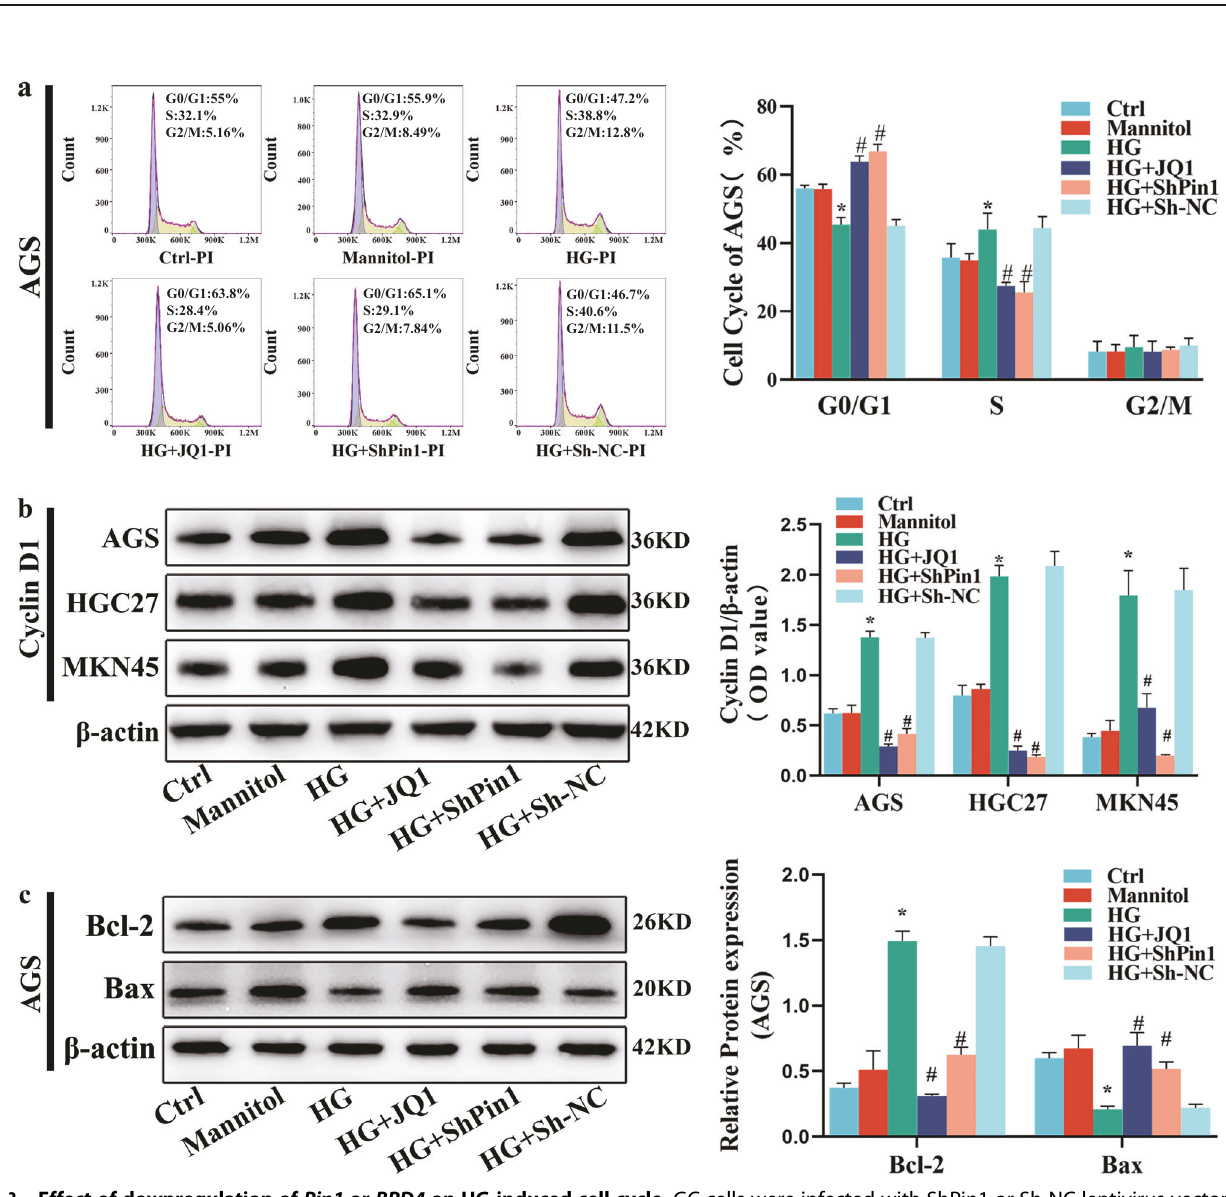
Fig. 2 Effect of silencing Pin1 or BRD4 on migration of GC cells induced by HG. a Wound-healing assay was used to measure migration of AGS. AGS was treated with JQ1 (10 − 6 M) and incubated with HG for 24 h. Scale bars, 100 μ m. Values are mean ± SEM. * P < 0.05 vs. Ctrl; ## P < 0.01 vs. HG. b Wound-healing assay of AGS transfected with the lentivirus vector of ShPin1 or Sh-NC. Scale bars, 100 μ m. Values are mean ± SEM. * P < 0.05 vs. Ctrl + Sh - NC; ## P < 0.01 vs. HG + Sh-NC. c Transwell assays were used to measure migration of AGS. Scale bars, 100 μ m. Values are mean ± SEM. * P < 0.05 vs. Ctrl; ## P < 0.01 vs. HG. d MMP9 proteins were extracted from cells for WB. β -actin served as the loading control. Values are mean ± SEM. * P < 0.05 vs. Ctrl; # P < 0.05 vs. HG. All the experiments were performed 3 times.